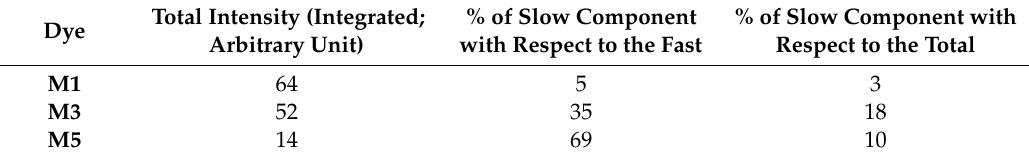
Table 4. Values of the total intensity and the relative percentage for the slow and fast component. Total Intensity (Integrated; % of Slow Component with % of Slow Component with Dye Arbitrary Unit) Respect to the Fast Respect to the Total M1 64 5 3 M3 52